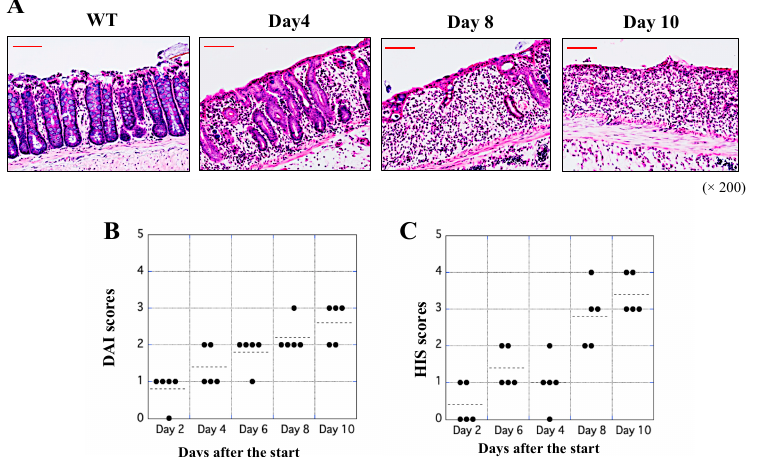
Figure 2. Evaluation of disease severity. H&E staining was performed to visualize histological changes in the rectal tissues of WT and UCR. ( A ) Microscopic images of the rectal tissues of WT and UCR on Days 4, 8, and 10 after the start of the experiments. High power magnification was used for all panels (×200). Red scale bar = 50 μ m. ( B,C ) DAI and HIS scores on Days 2, 4, 6, 8, and 10 after the start of the experiments were assessed based on the criteria of Tables 1 and 2. Dotted points indicate average measurements on each day. WT: wild type Slc:Wistar rats; UCR: Slc:Wistar rats treated with 5% dextran sulfate sodium; DAI: disease activity index; HIS: histological.